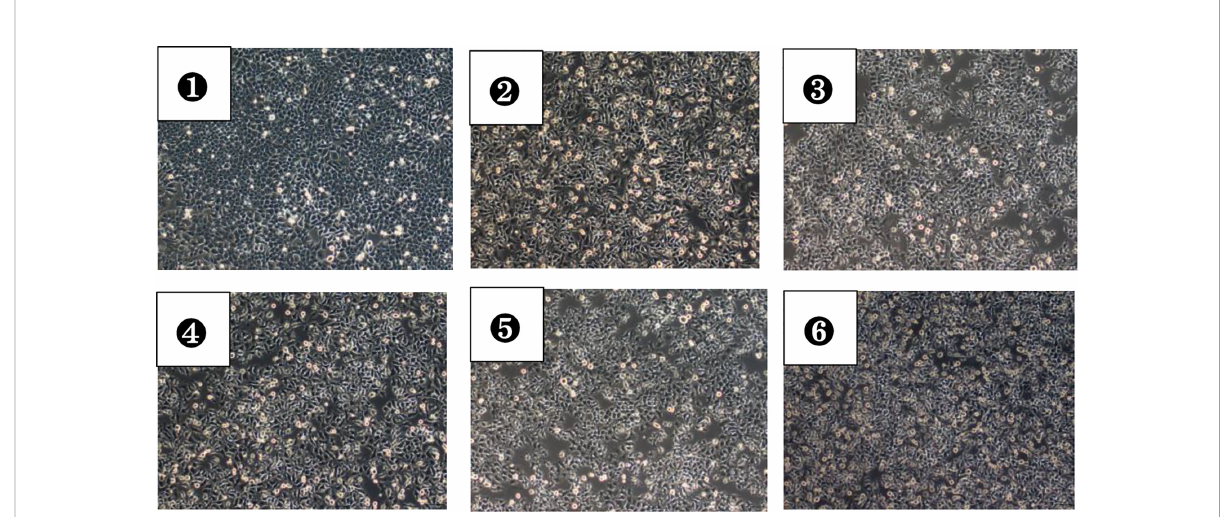
FIGURE 2 HepG2 cells in each group after 48 hours of culture (magni fi cation, ×100). ① A photo of cell growth in the HepG2 group; ② A photo of cell growth in the HepG2+VAT group; ③ A photo of cell growth in the HepG2+SAT group; ④ A photo of cell growth in the HepG2+VAT+EXE group; ⑤ A photo of cell growth in the HepG2+SAT+EXE group; ⑥ A photo of cell growth in the HepG2+TritonX-100